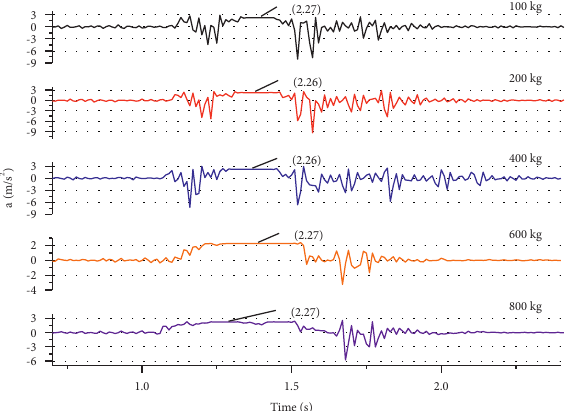
Figure 13: Longitudinal vibrations of the hoist rope during the downward emergency